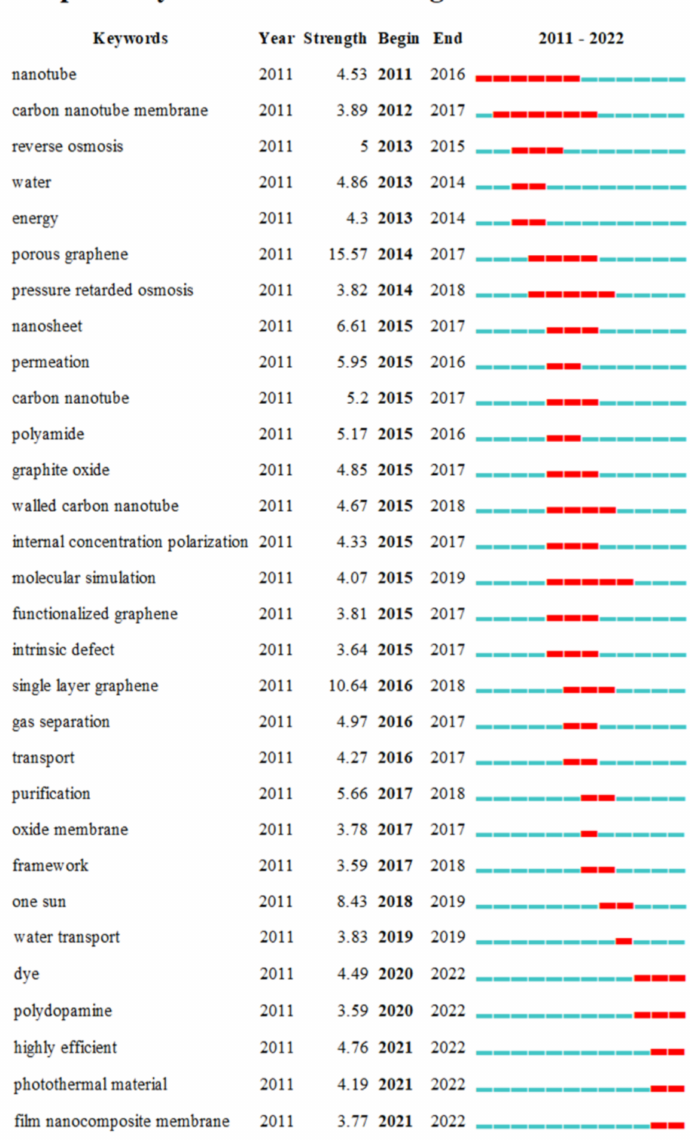
Figure 6. Burst keywords analysis based on publications from 2011 to 2022. The red represents the burst time.